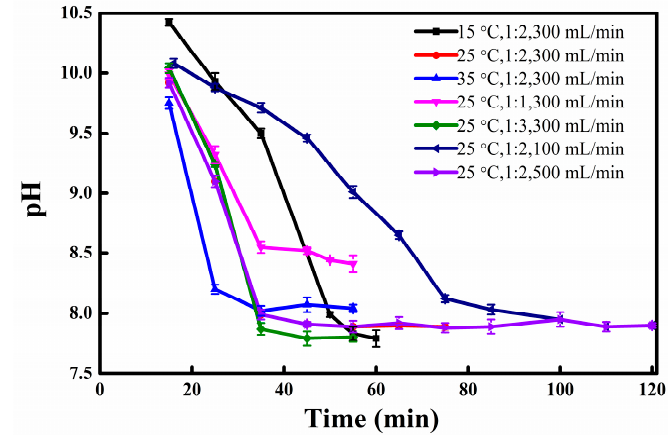
Figure 5. The variation of solution pH as a function of reaction time at different temperatures, Et 3 N/H 2 O volume ratios, and CO 2 injecting rates.